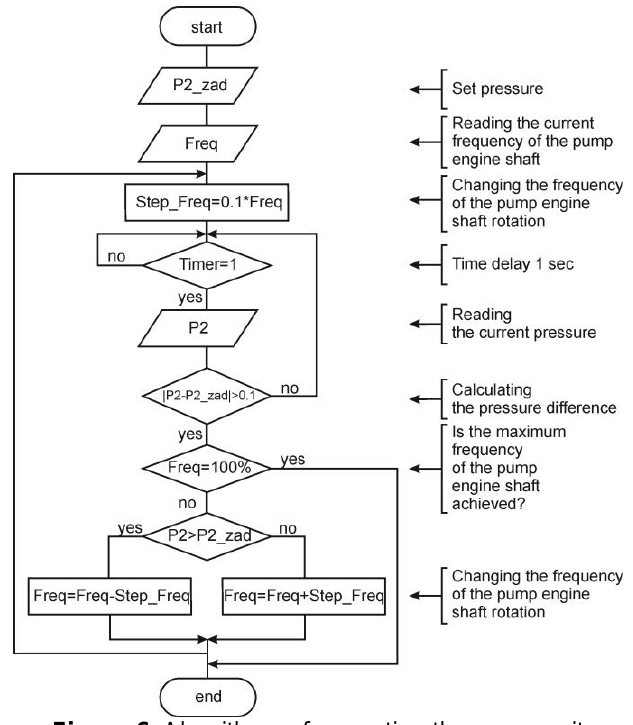
Figure 6. Algorithms of correcting the pump unit engine shaft rotation frequency